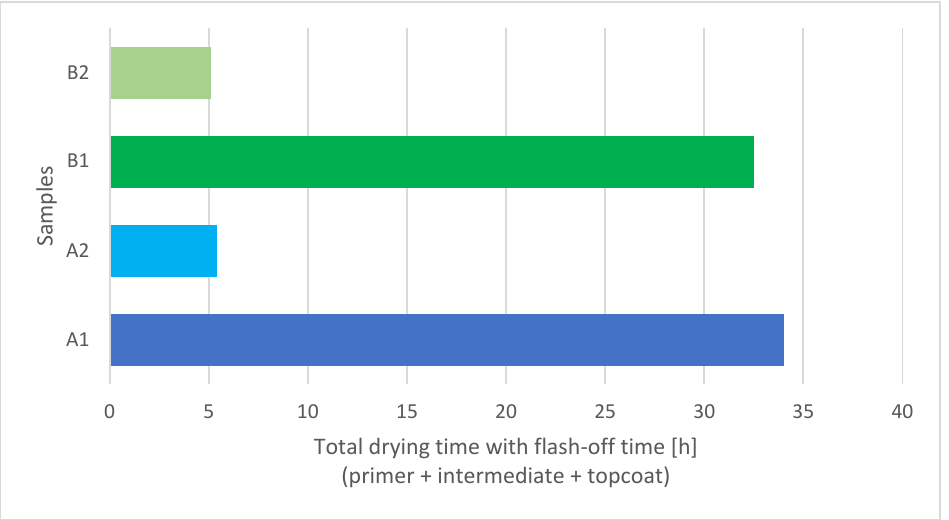
Figure 5. Comparison between drying times of IR (A2, B2) and air ‐ dried (A1, B1) three ‐ layer water ‐ borne coating systems.